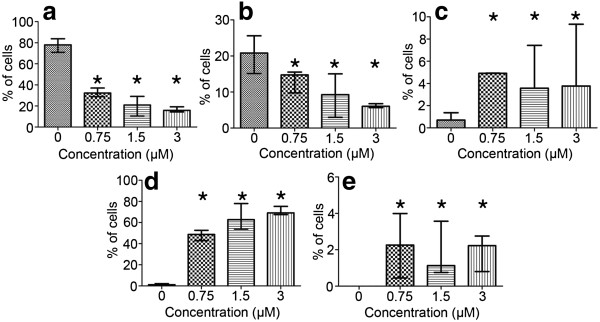
a-e Progressive changes in the morphology of nuclei in A549 cells after treatment with etoposide - statistical data from microscopic evaluation (staining with DAPI). a Cells with regular nuclei, b cells with nuclei of a regular size and with some morphological abnormalities (lobulation, invaginations, buds), c cells with nuclei indicative of apoptosis (apoptotic bodies), d cells with large nuclei, e cells with features of SAHF formation. Statistically significant differences as compared to the control cells are marked by asterisks (Mann–Whitney U statistics, P<0.05). Columns - median percentage of cells, bars - interquartile range. Results are representative of five independent experiments.